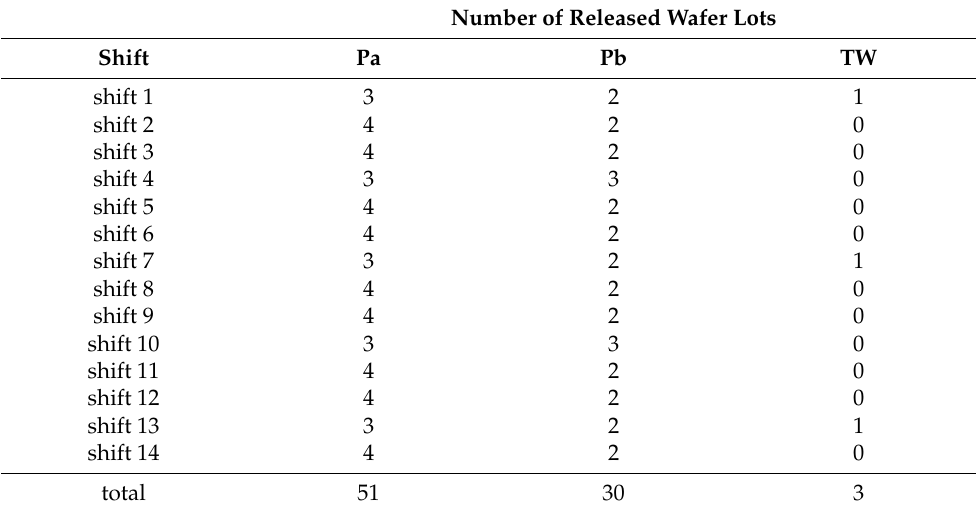
Table 2. Wafer lot release schedule per shift (for one